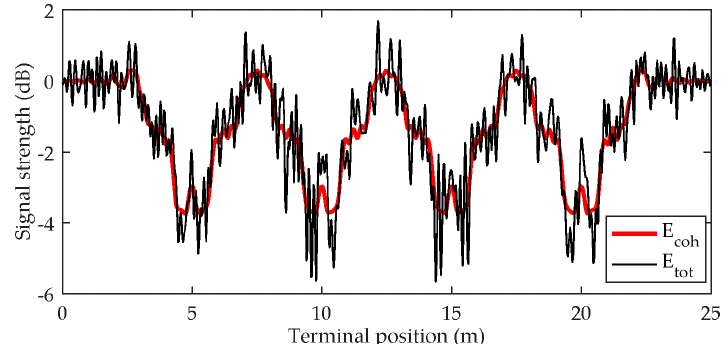
Figure 6. The coherent scattered field (red) and total resulting field (black) for the scenario from Figure 5.